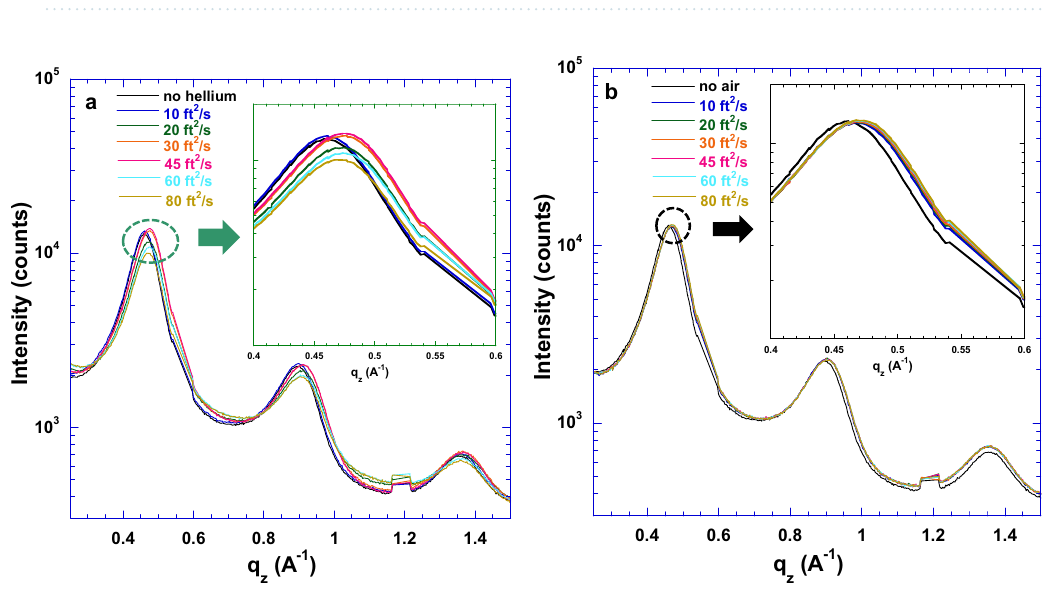
Figure 6. The 1D-GIWAXS patterns of the PEDOT:Tos thin film, ( a ) under different nitrogen flow rates, and ( b ) under helium with the flow rate of 20 ft 2 /s for different times.